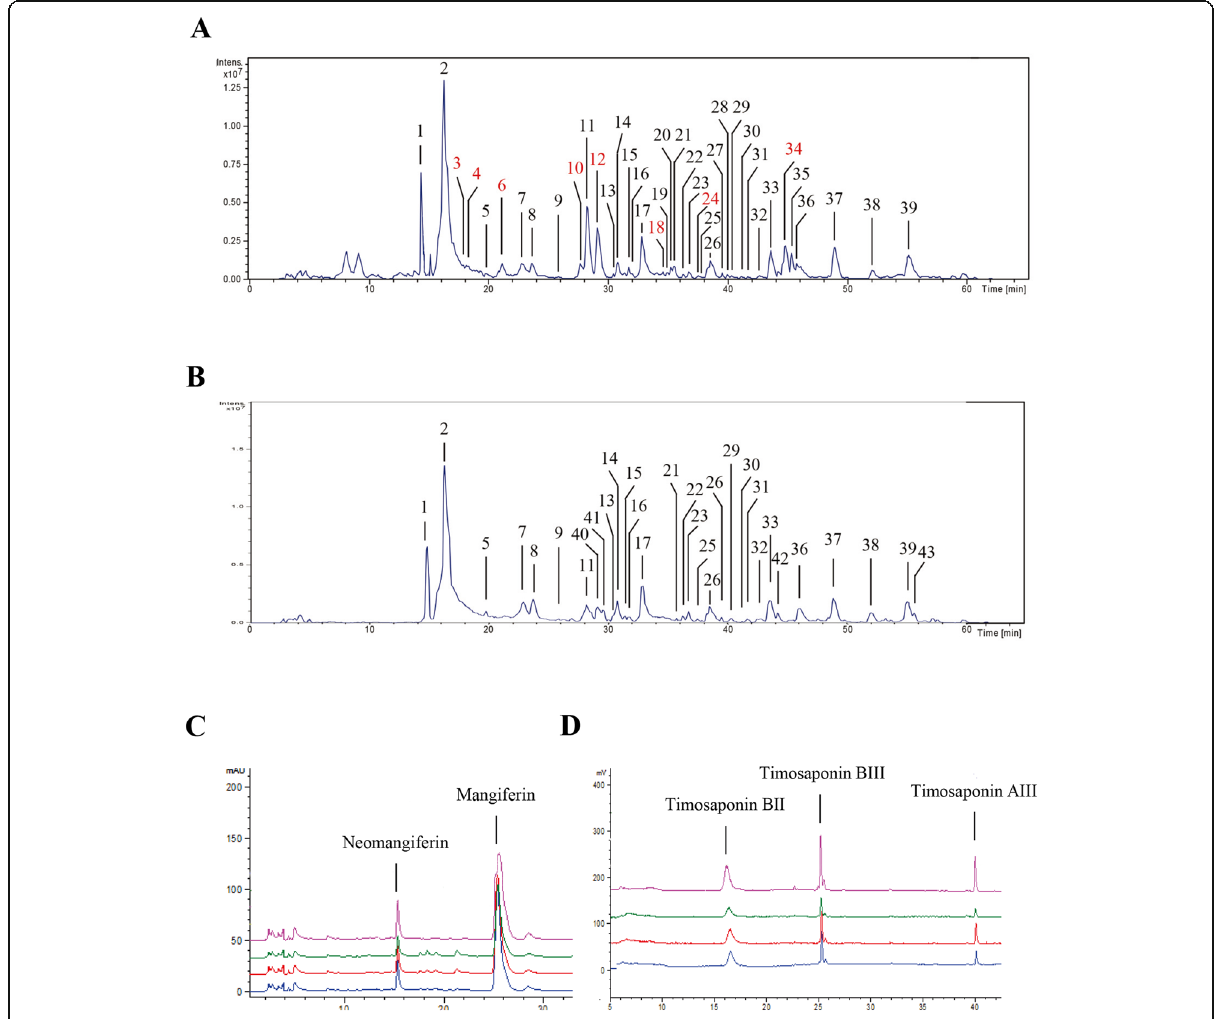
Fig. 1 Main components of Baihe Zhimu formula and Anemarrhena asphodeloides extract. a Thirty-nine compounds were identified in Baihe Zhimu (BZ) formula by HPLC-MS/MS in negative ion mode, as shown in Table 2. b Thirty compounds were identified in A. asphodeloides by HPLC-MS/MS, as shown in Table 3. The fingerprints of the main components in A. asphodeloides were analyzed by c HPLC-UV and ( d )